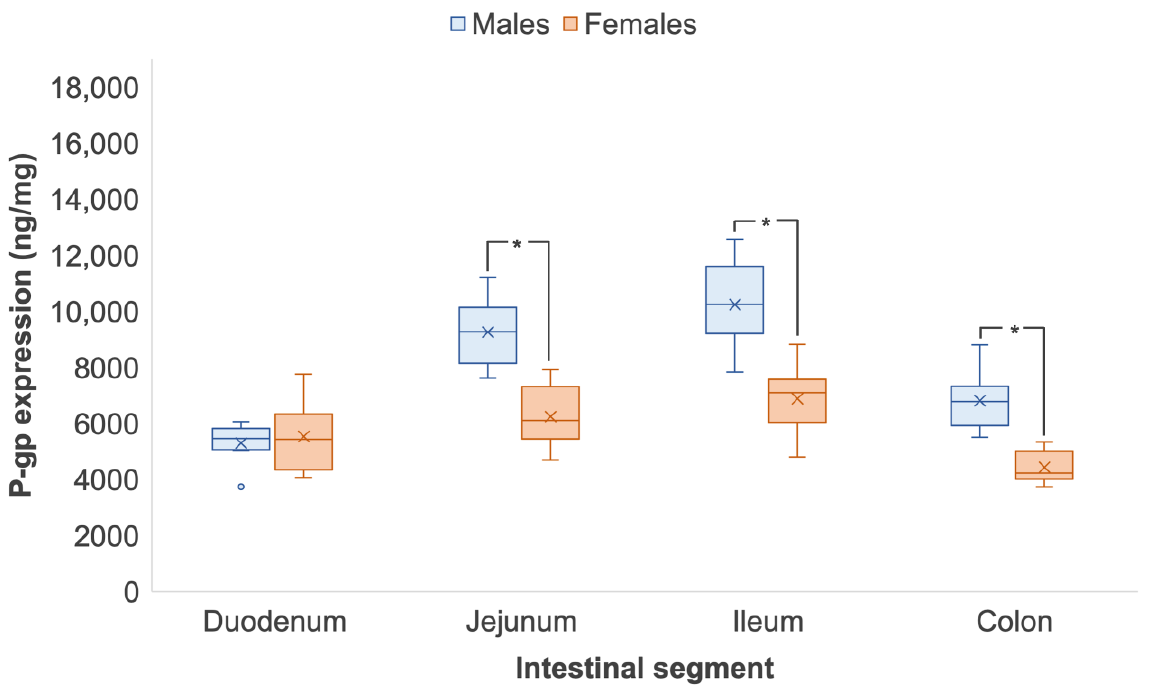
Figure 2. Regional and sex differences in P-gp expression in male and female Wistar rats quantified by LC-MS/MS. Data are represented as mean ± S.D., n = 8. The * symbol denotes statistical significance between the sexes in an intestinal region ( p < 0.05). Regional differences are statistically significant from the small intestinal segments to the colon ( p < 0.05).